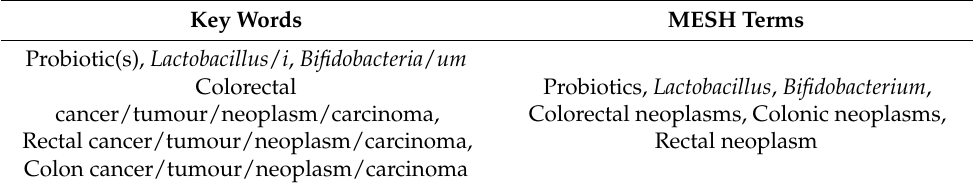
Table 1. Keywords and MeSH terms used to search Embase, Medline, and Cochrane through